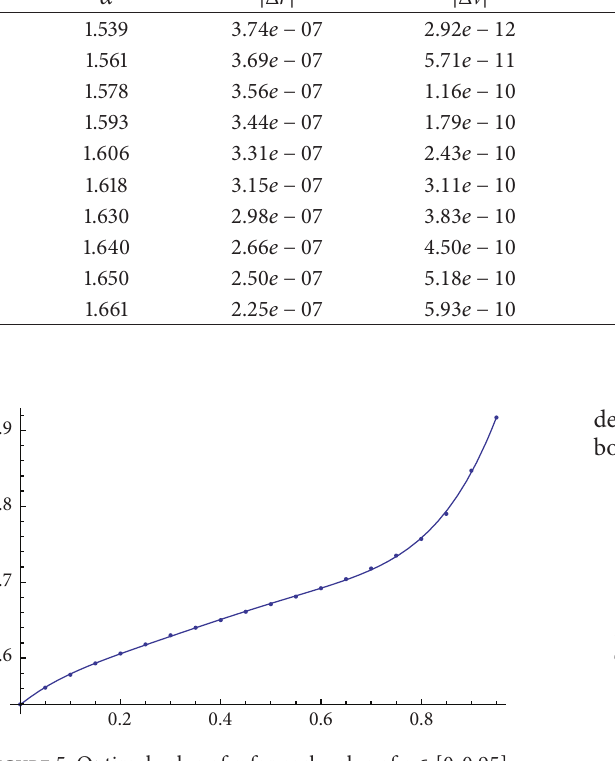
Figure 5: Optimal value of 𝛼 for each value of 𝑒 ∈ [0,0.95]